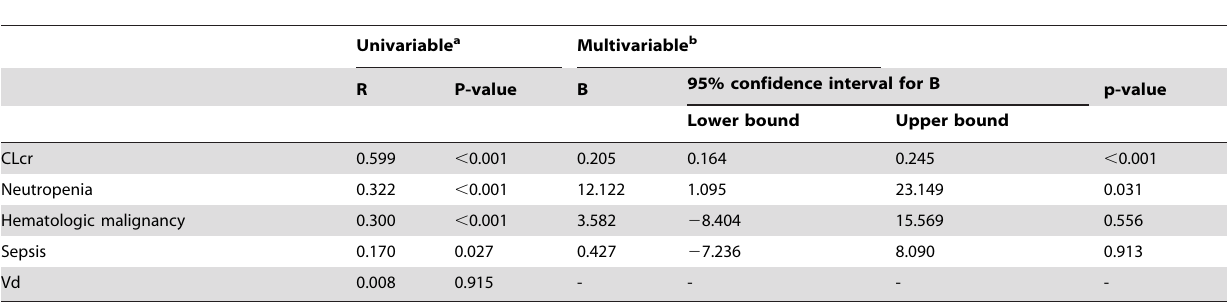
Table 3. Univariable and multivariable correlation coefficients between CLva and predictors used in this